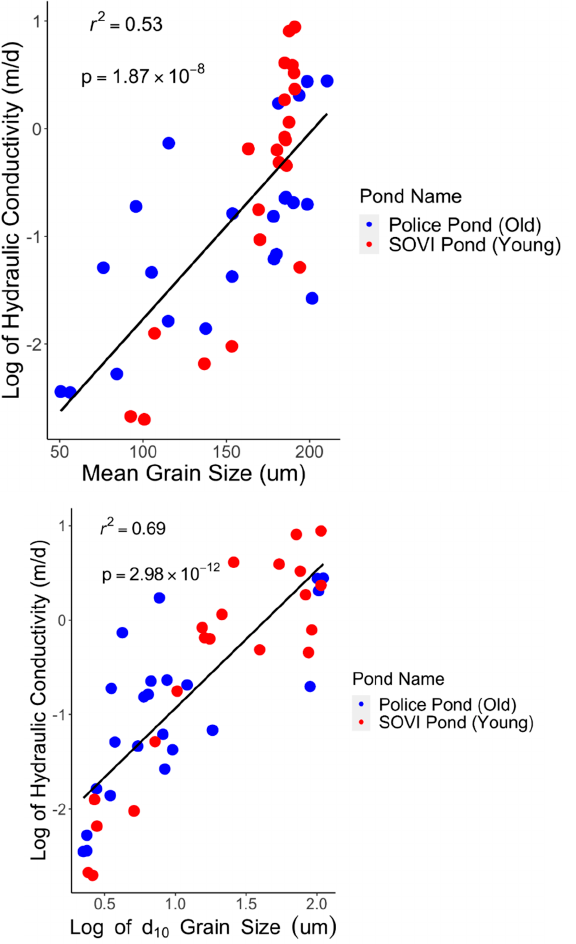
Figure 7. Measurements of the log of hydraulic conductivity with the mean grain diameter of the bottom sediment ( top ) and measured log of hydraulic conductivity with the log of the median d 10 grain size value ( bottom ).